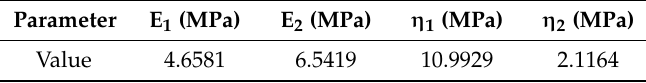
Table 7. Macro parameters of AC-16 asphalt mastic.